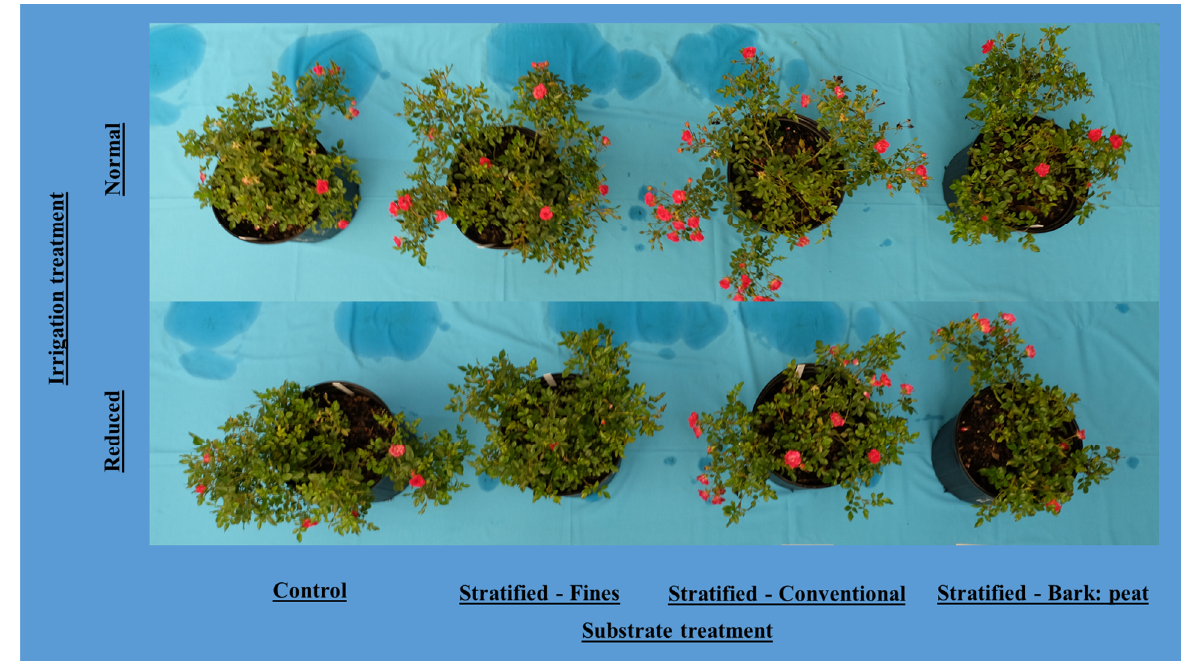
Figure 3. Top view of Drift roses 125 days after initiation. Roses were grown utilizing either a conventional pine bark substrate (control) or stratified substrates, in which either conventional pine bark substrate amended with 35% peat (by vol.; bark–peat), conventional pine bark (conventional), or fine pine bark (fines) was layered on top of coarse screened pine bark. Plants were irrigated with 16 mm (normal; control) or 12 mm of water daily (reduced).